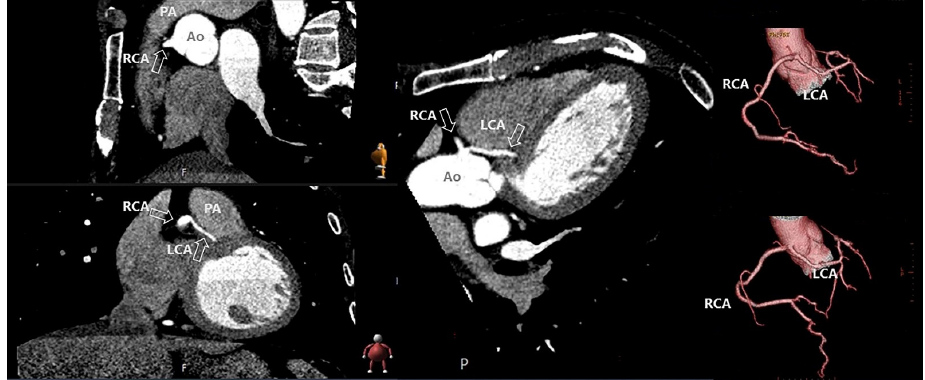
Figure 6. Coronary anomaly visible and diagnosed with computed tomography. The figure shows the anomalous origin of the left coronary artery (LCA) from the right sinus of Valsalva with the LCA between the aorta and the pulmonary artery. Ao: aorta; PA; pulmonary artery; RCA; right coronary artery.